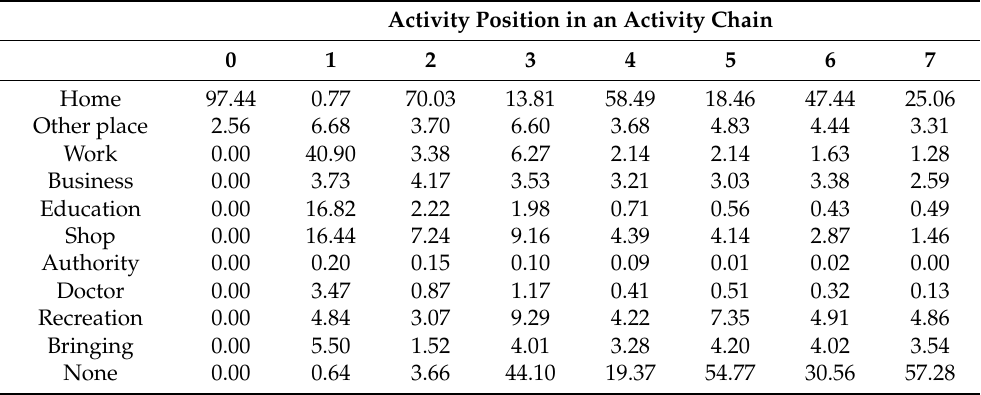
Table 1. Probability distributions of activity types (%) in columns depending on an activity position in an activity chain